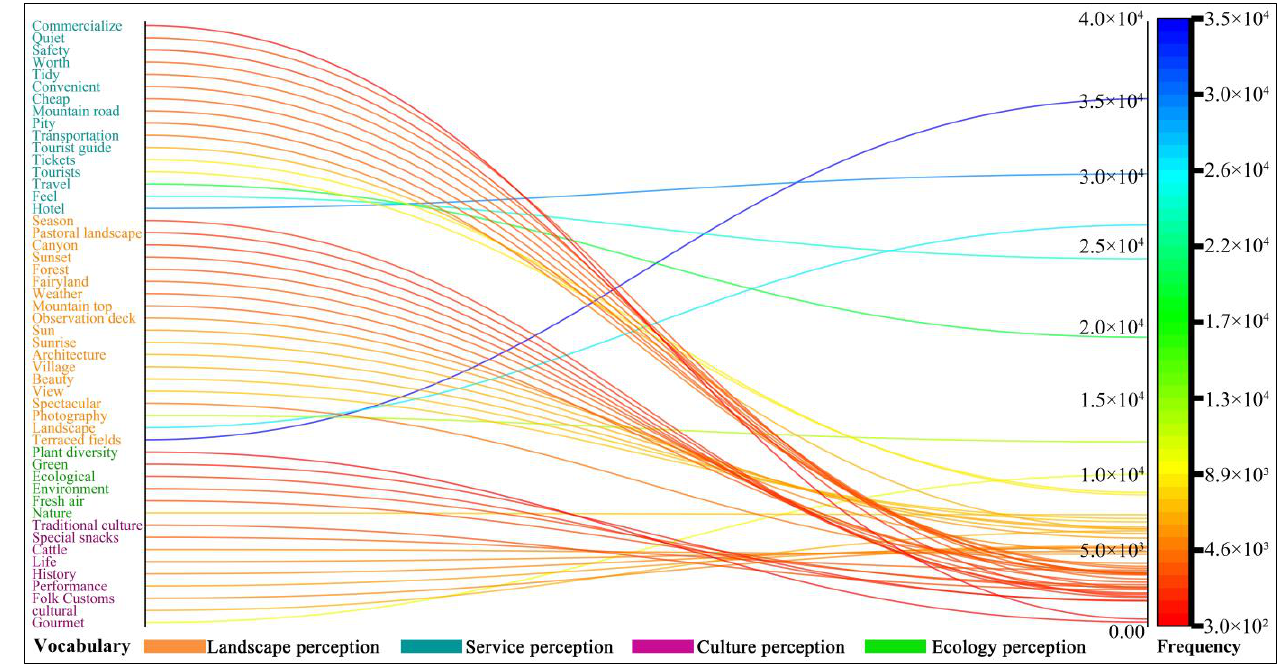
Figure 1. Top 50 high-frequency feature words (after merging synonyms).